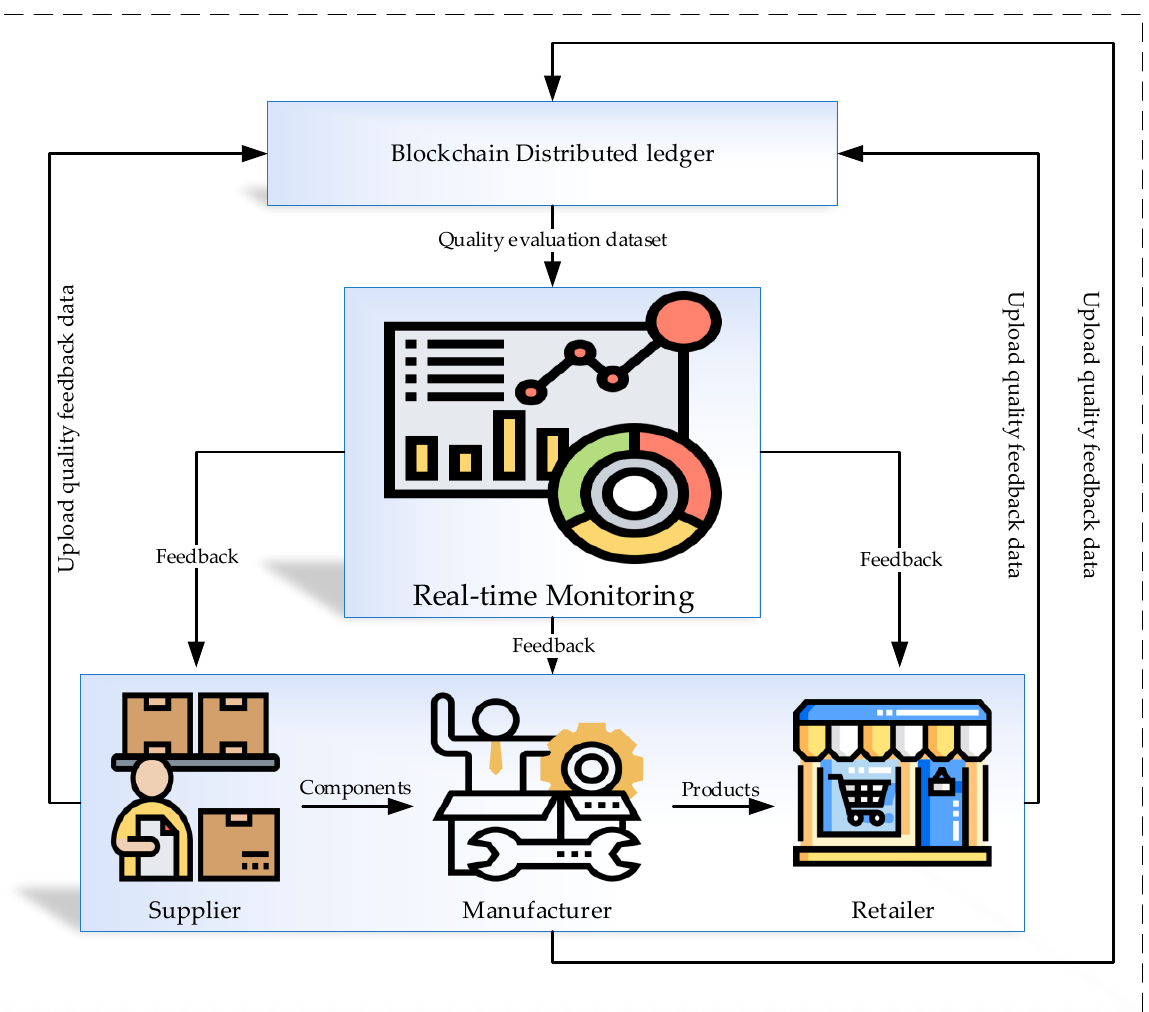
Figure 3. Real-time controlling and quality